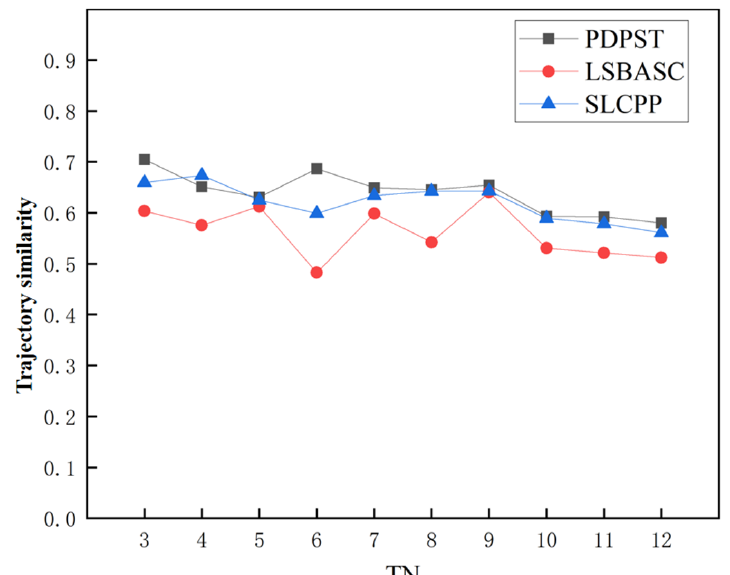
Figure 13. Trajectory similarity.